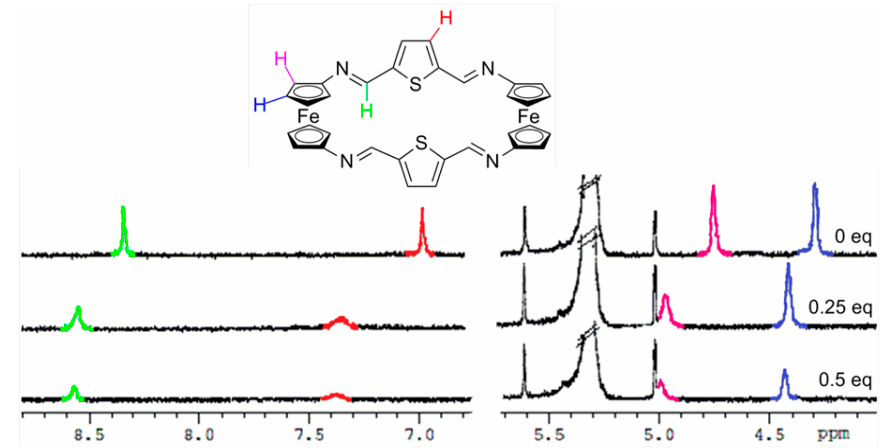
Figure 5. Evolution of the 1 H-NMR spectrum of the free ligand 4 , in CD addition of increasing amounts of Pb 2+ until 0.5 equiv. The crossed signal corresponds to the